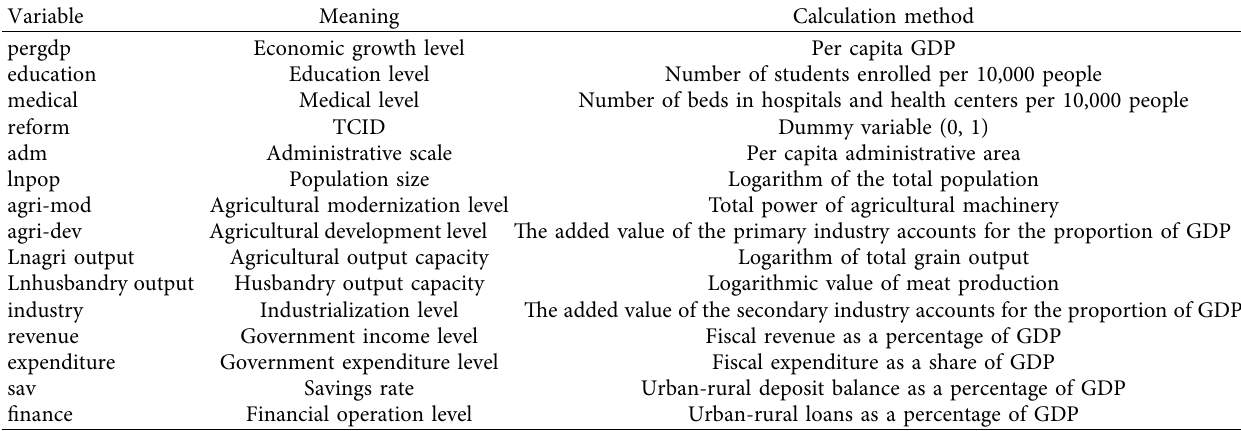
Table 1: Main variables and calculation